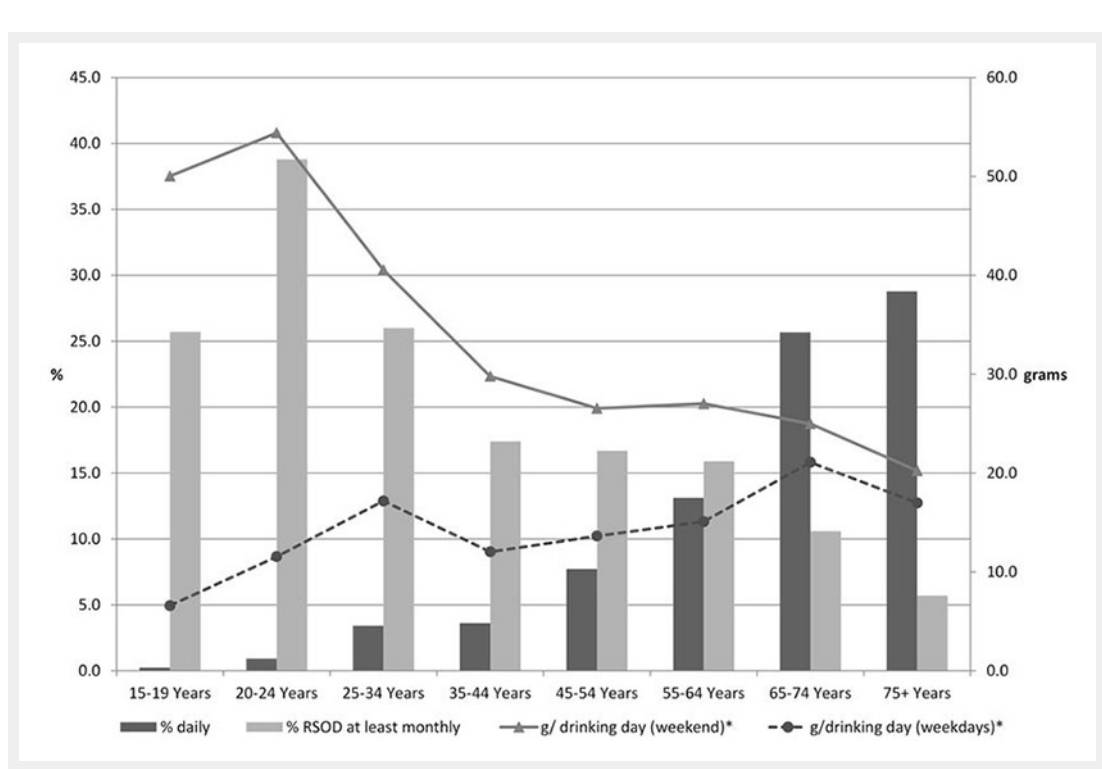
Percentage of daily and risky single occasion drinkers (RSOD) and grams of alcohol consumed on weekend days and weekdays by age group in 2011. Note: *among drinkers only (n = 5,840); data from Addiction Monitoring in Switzerland financed by the Federal Office of Public